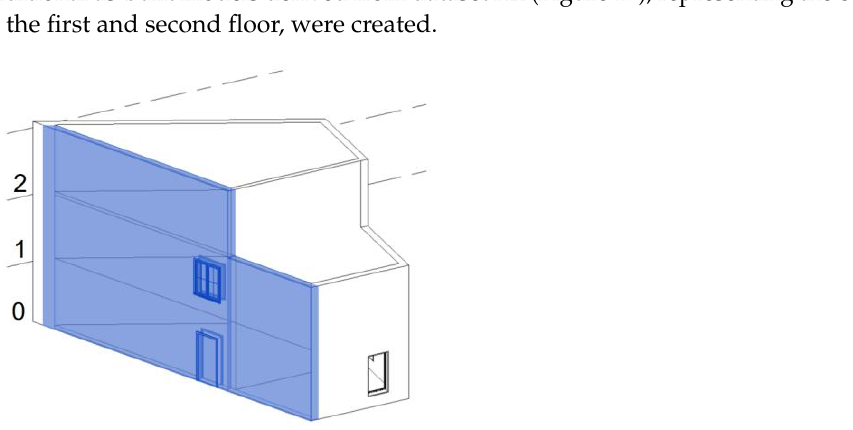
Figure 16. Graph showing the effect on RMSE of increasing the number of RANSAC iterations.